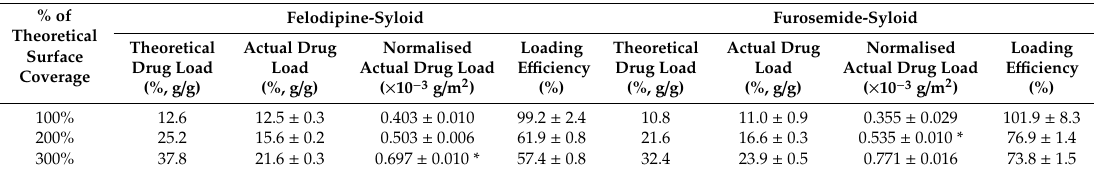
Table 1. Drug loads and loading e ffi ciency of Felodipine and Furosemide in mesoporous silica Syloid XDP 3050 (surface area of 310 m 2 /